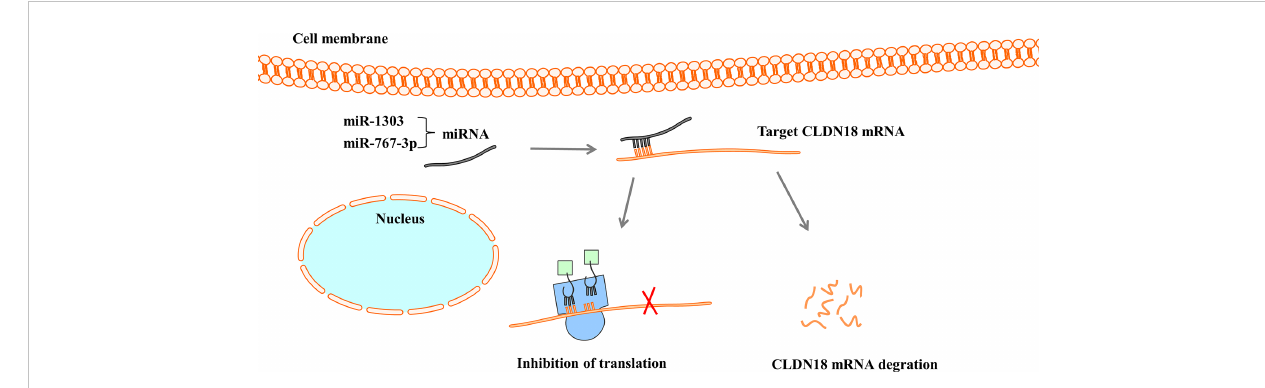
FIGURE 5 MiRNAs regulate the expression of CLDN18. MiRNAs bind with 3 ’ -UTR of CLDN18 mRNA, resulting in the degradation of mRNA or the inhibition of